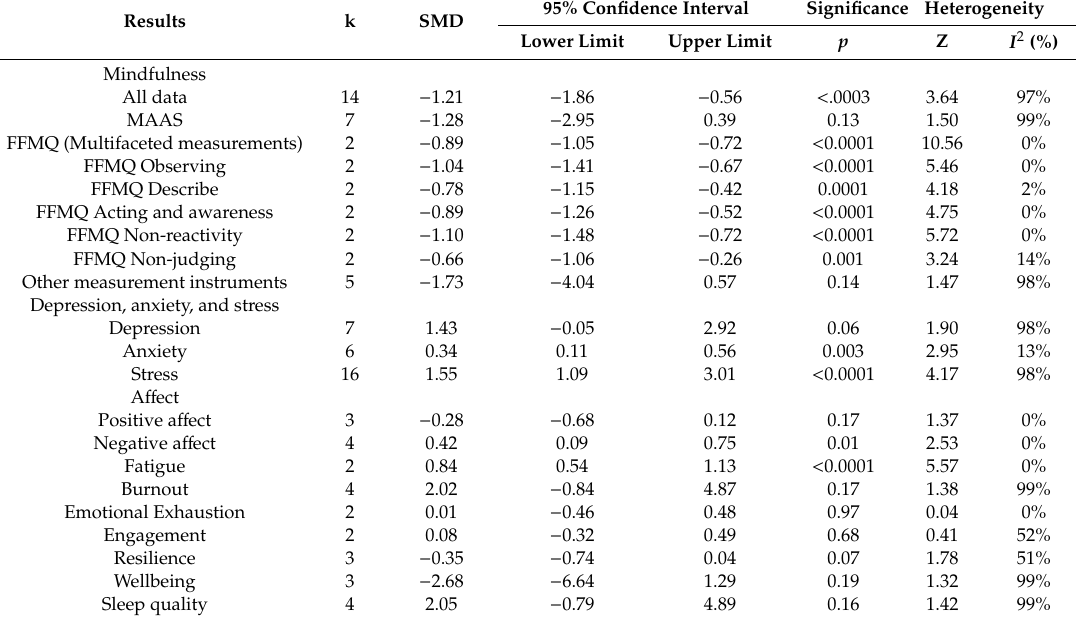
Table 2. Mindfulness in the workplace and influence with di ff erent variables (meta-analytical estimates of e ff